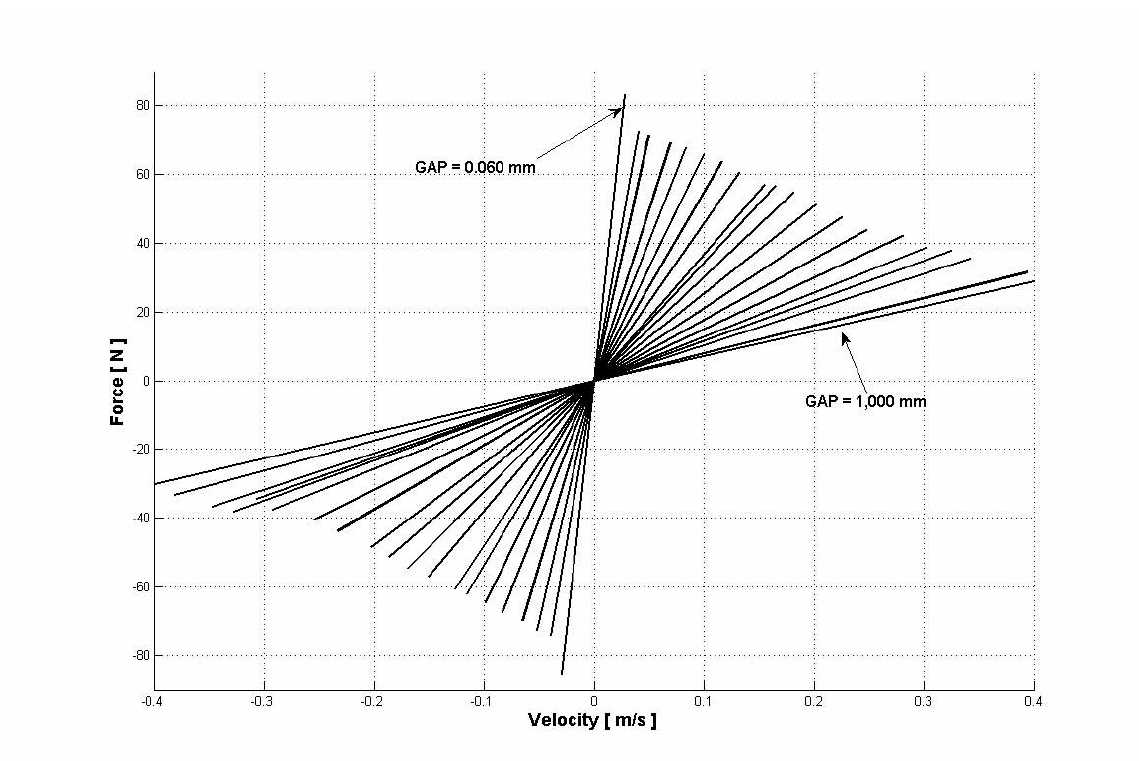
Fig. 9. Experimental relation between the damping force and the velocity for different GAP values. Smaller ratio values (B and C) are unable to represent the damping coefficient for small GAP values. Better, but not perfect fitting is achieved for the larger ratio (A). As mentioned before, increasing the bulk modulus-viscosity ratio, the integration time step must be reduced and even so the numeric convergence is not always